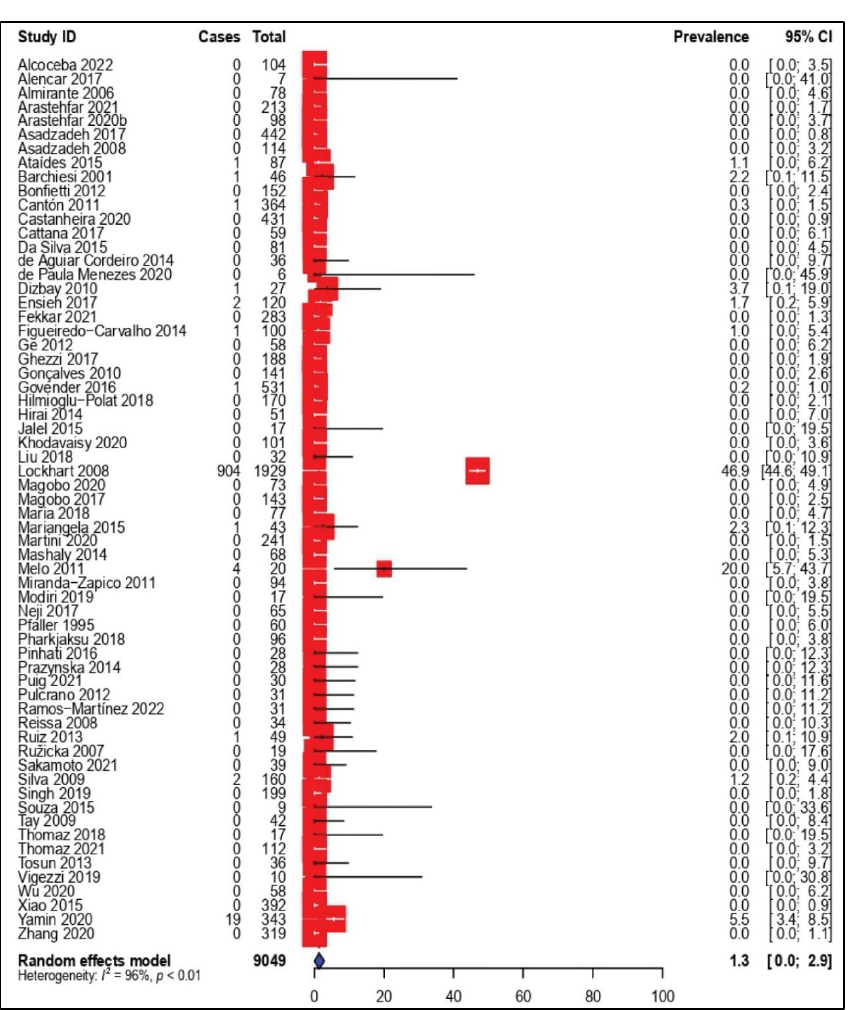
Figure 3. Forest plot representing the pooled prevalence of Amphotericin B-Resistant Candida parapsilosis isolates.